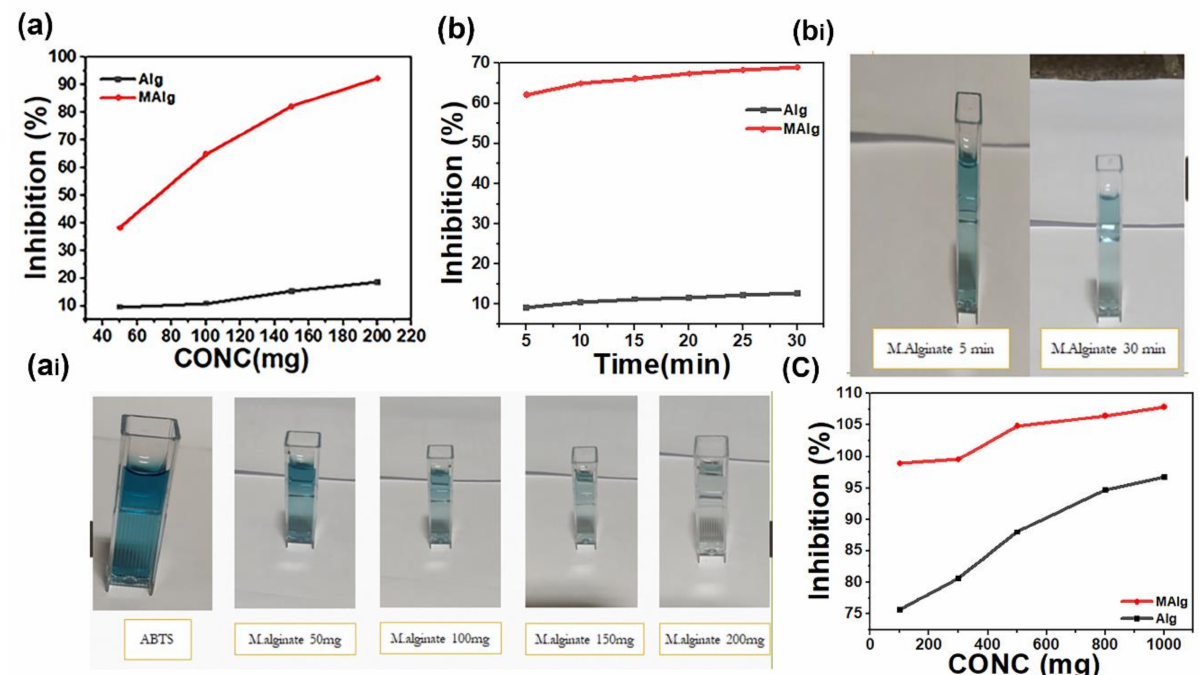
Figure 8. ABTS free radical scavenger activity of Alginic acid and its aromatic derivative. ( a ) with conc. ( ai ) decolorization of ABTS with conc. ( b ) with time. ( bi ) decolonization of ABTS with time. ( c ) scavenger activity of Alginic acid and its aromatic derivative against DPPH